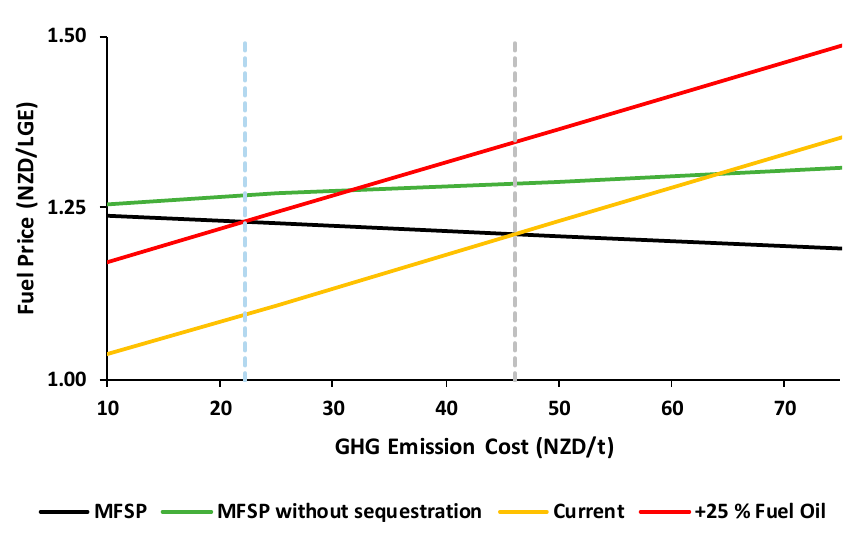
Figure 6. E ff ect of the carbon price on the fuel selling Figure 6. Effect of the carbon price on the fuel selling price.